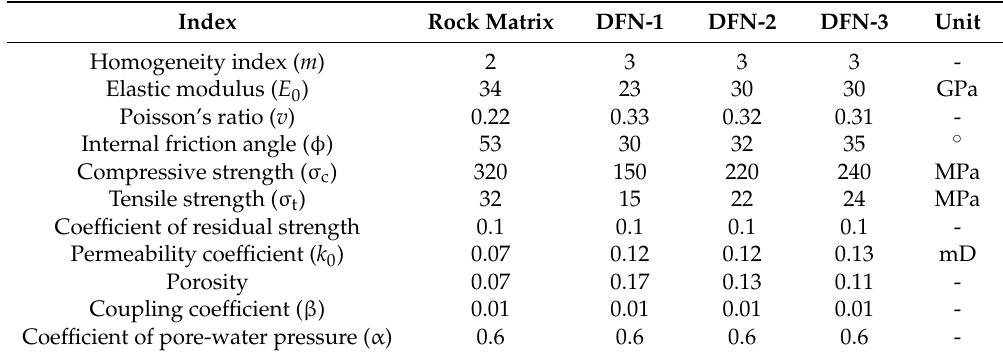
Table 1. Input material mechanical parameters for the studied numerical